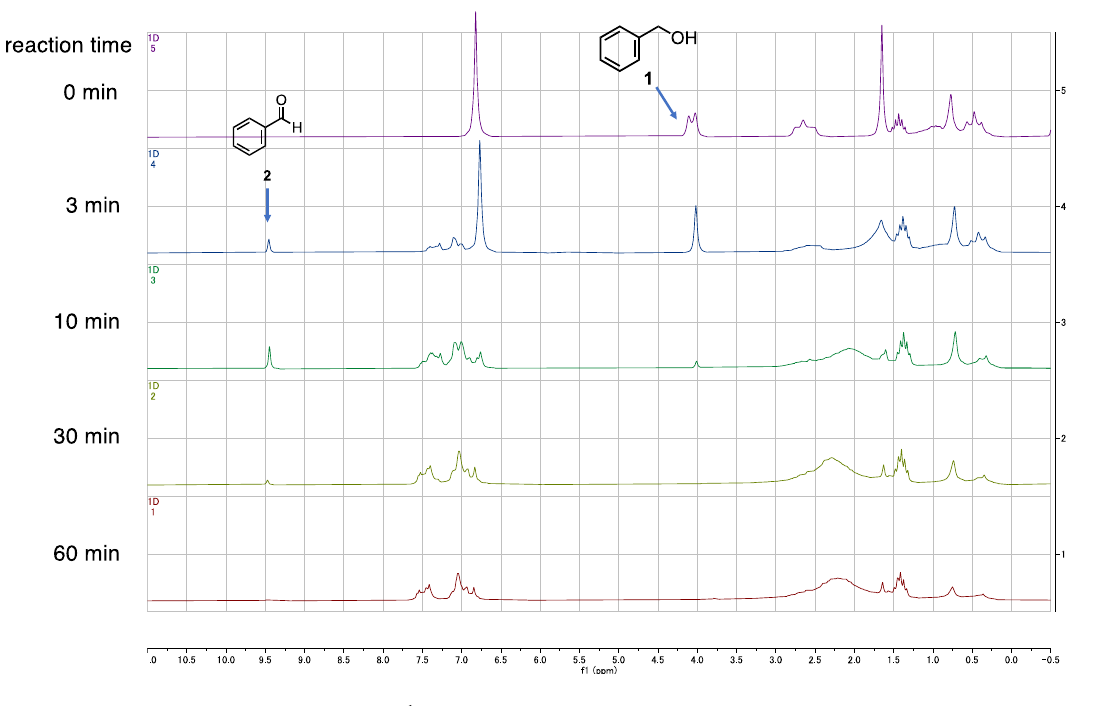
Figure 3. Effect of irradiation power for a 1 h reaction of 1 with O 2 .